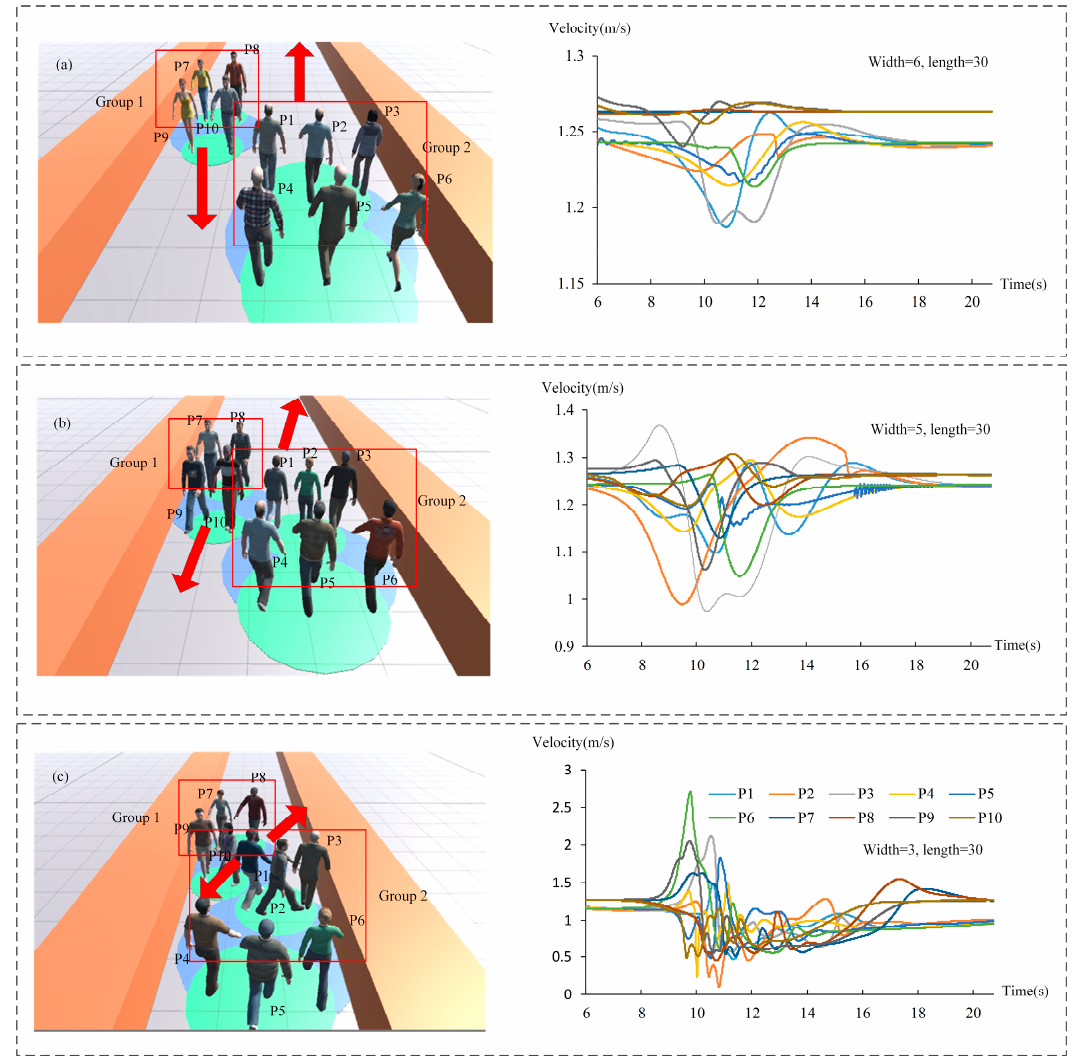
Figure 6. Group avoidance patterns in a long corridor with different widths and corresponding speed curves; P1–P10 are pedestrians in the pictures. ( a ) groups will not evade while the corridor is spacious. ( b ) Groups will slightly adjust if the space is not adequate, and Group 1 takes the initiative to avoid. ( c ) Groups will make major adjustments if the corridor is narrow.